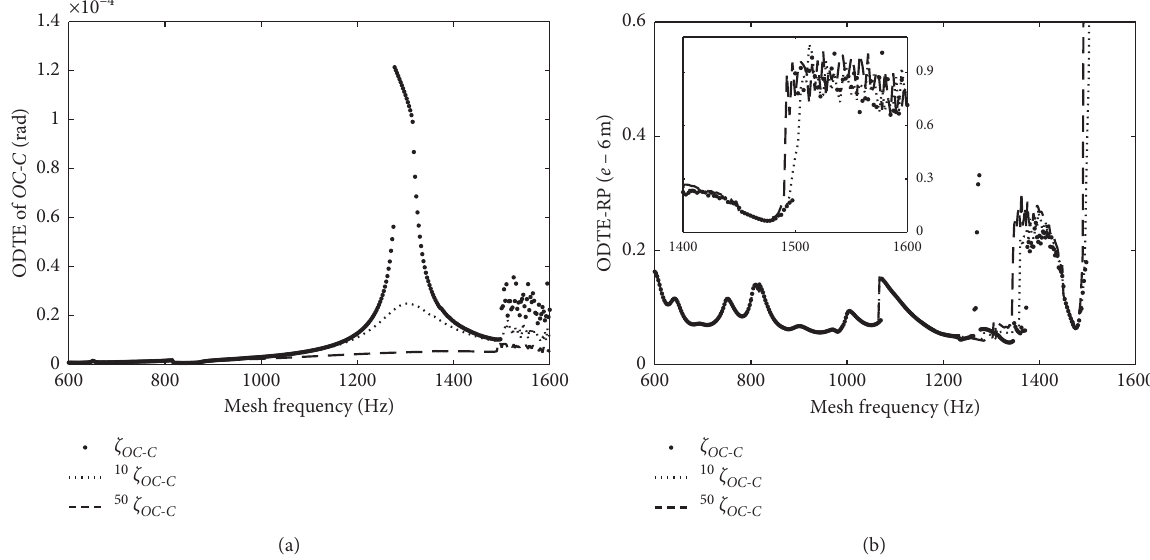
Figure 13: Nonlinear dynamics of the unit as damping ratio of SOWC-C changed: vibration characteristics of (a) SOWC-C and (b)